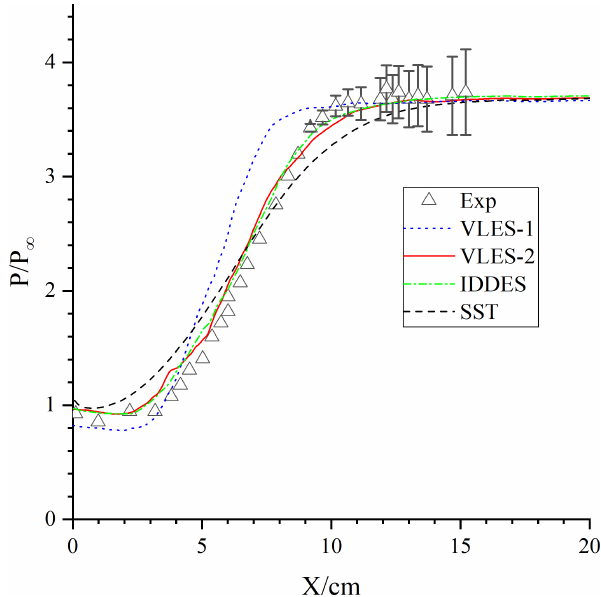
Figure 5. Comparisons of wall pressure distributions of different turbulence